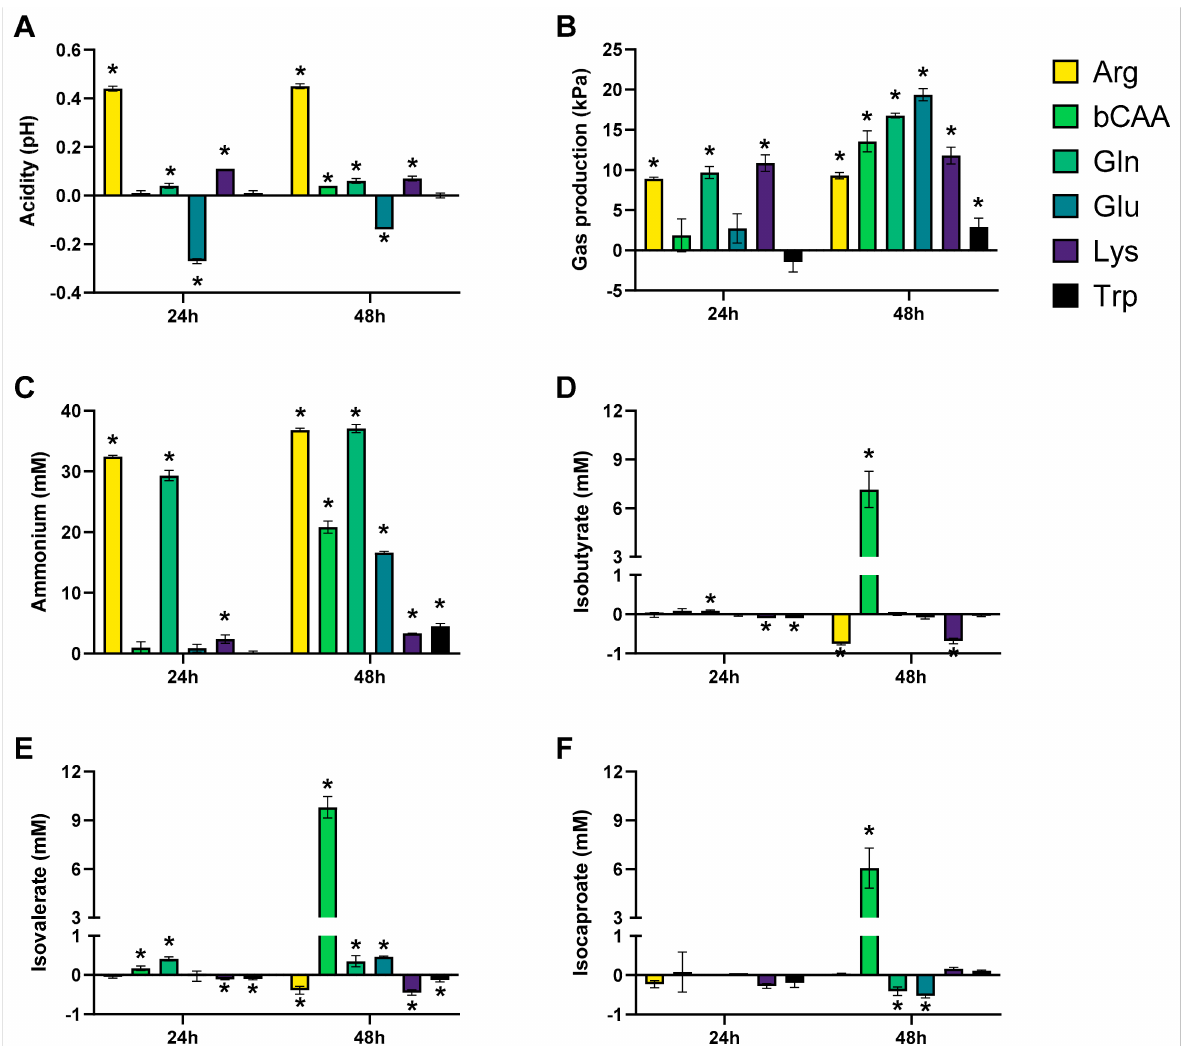
Figure 3. Effect of amino acids on acidity (pH) ( A ), gas production (kPa) ( B ), and markers of proteolytic fermentation (ammonium ( C ) and bCFA (isobutyrate ( D ), isovalerate ( E ), and isocaproate ( F ))) upon incubation with a porcine colonic microbiota ( n = 3). The data is presented as the average ( ± SD) difference versus a corresponding blank incubation. Statistically significant differences are indicated with asterisks (* p <